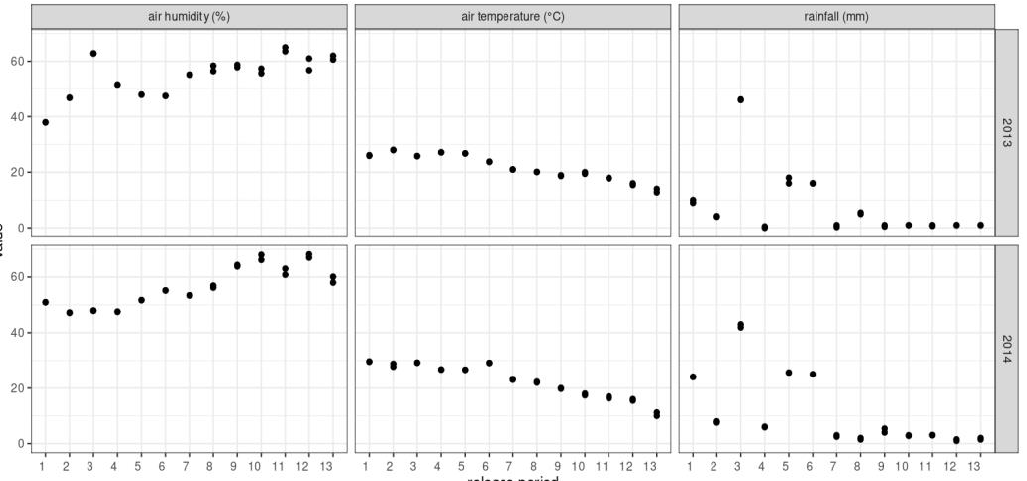
Figure 1. Mean ( ± SD) values of temperature (Temp.) and relative humidity (RH), and cumulative rainfall (CR) recorded every 12 days between December and June of both study seasons (December 2012–June 2013 and December 2013–June 2014) on two experimental irrigated fruit farms in Rivadavia District, San Juan Province, central–western Argentina.